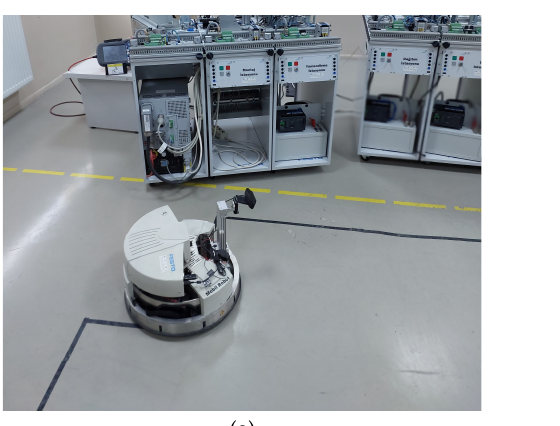
Figure 10. ( a ) In the case of mobile robot mapping. ( b ) QR code reader screenshot during physical test.